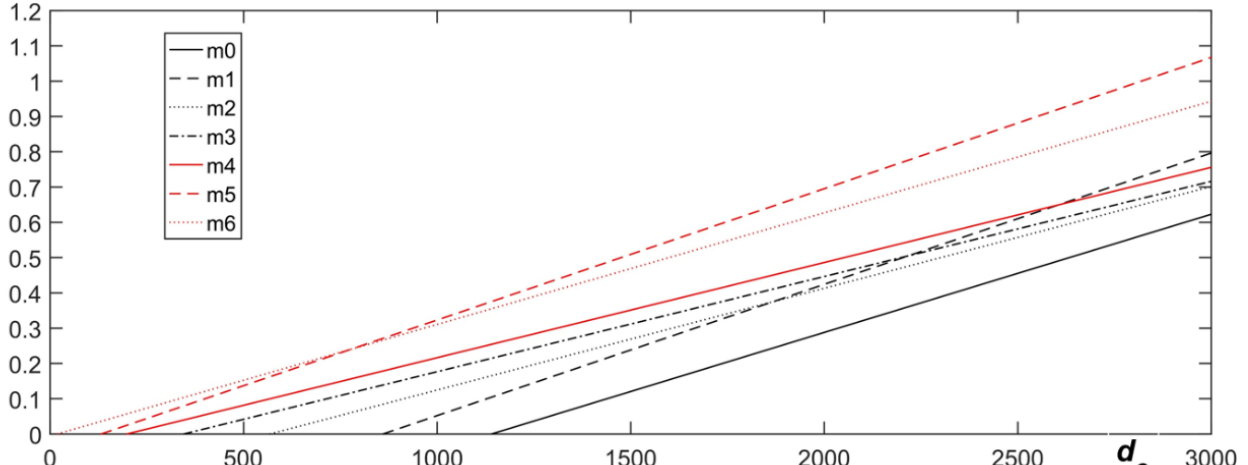
Figure 16. Bottleneck vulnerability delay and its evolutional curve. Apart from the distinct temporal and spatial characteristics when determining the null points, the evolutional curve of vulnerability is closely sensitive to the failure rate of m i and the service rate of the line. As shown in Figure 15 and Equation (52), terminal vul- nerability is quite sensitive to failure rate i λ and the average processing speed of the last queue, while bottleneck vulnerability is determined by the average processing speed of the bottleneck. This paper affords an analytical model of vulnerability evaluation under sudden dis- ruptive events. The computing speed of the analytical model is faster than the normal event simulation model. The proposed vulnerability evaluation model is the basis (mainly the four performance indicators) for further quick decisions (such as reconfiguration op- timization) under disruptions in the digital twin system. The four performance indicators are steady results. To verify them, we use Plant Simulation software to build the simula- tion model shown in the Figure 17, and conduct simulation experiments.